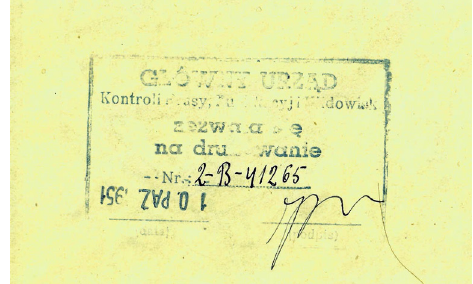
Fig. 6. Censor signatures. Head Office for Control of Press, Publications and Public